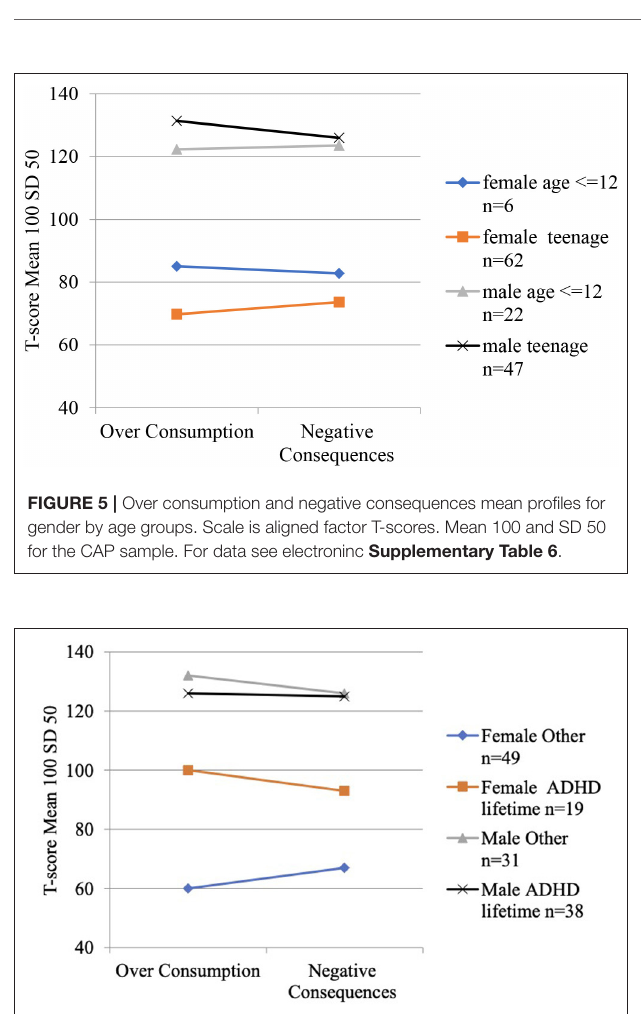
FIGURE 6 | Over consumption and negative consequences mean profiles for gender by ADHD lifetime diagnosis groups. Scale is aligned factor T-scores. Mean 100 and SD 50 for the CAP sample. For data see electroninc Supplementary Table 6